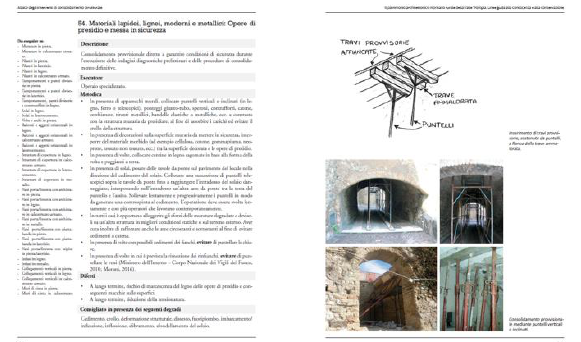
Figure 8. Example of an intervention data sheet.